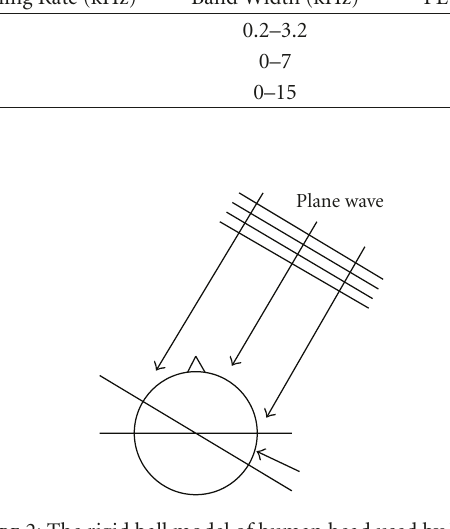
di ff erence. Both discoveries are derived based on the rigid ball modeling of head (Figure